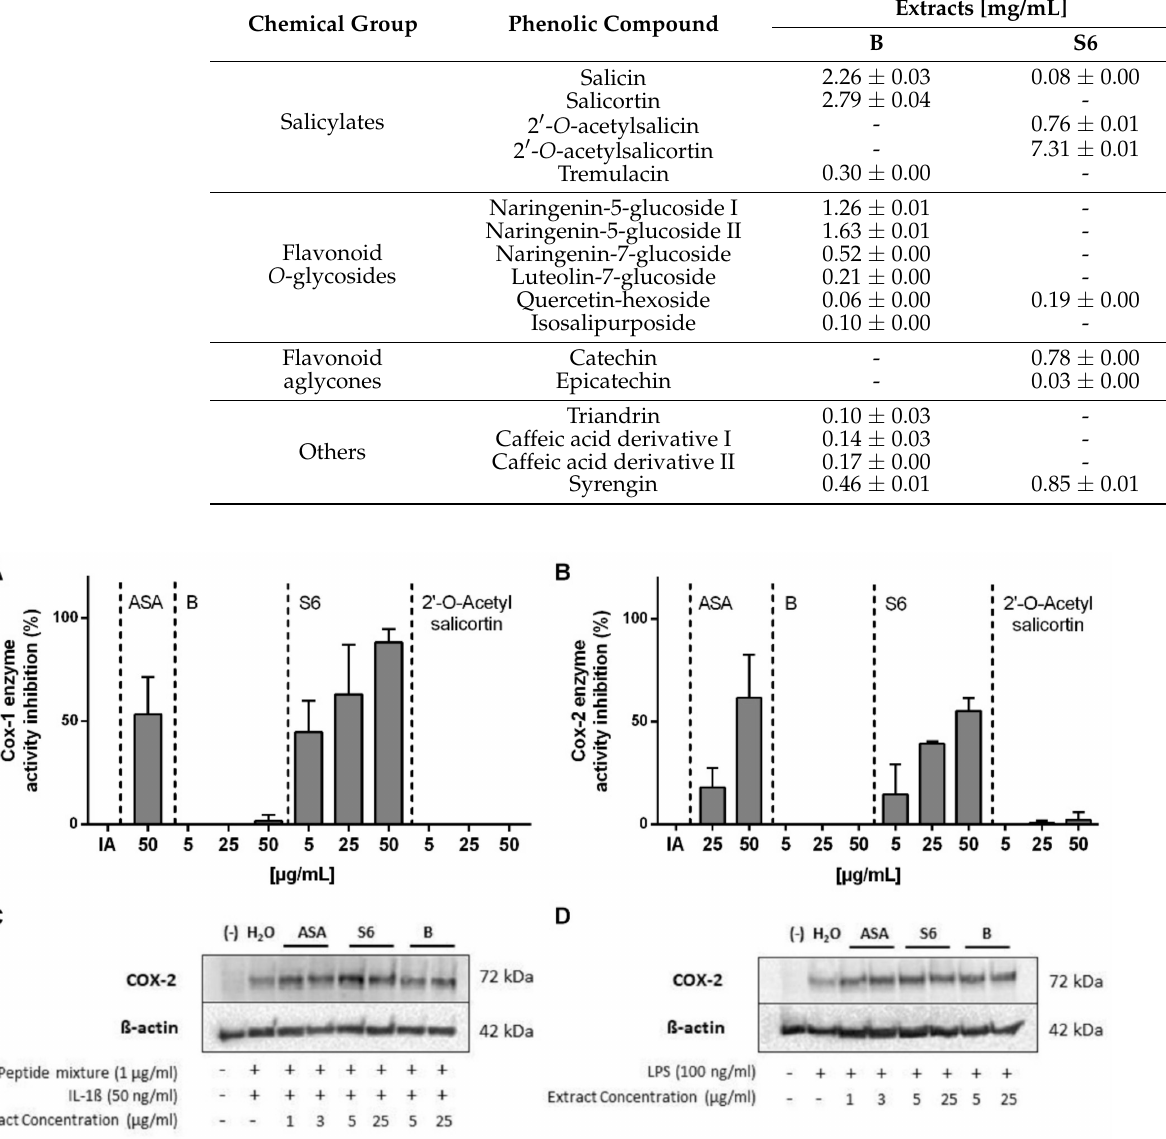
Table 1. Phenolic compounds quantified in 10 mg/mL Salix extracts.